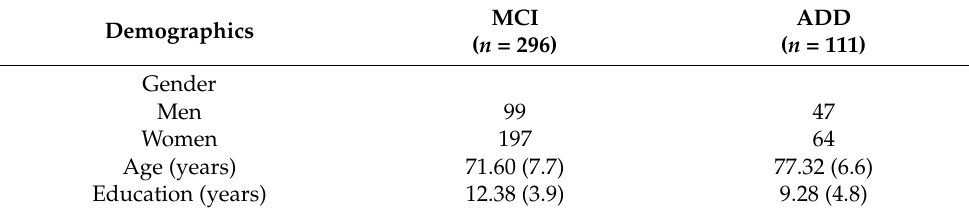
Table 1. Demographics in MCI and ADD participants.